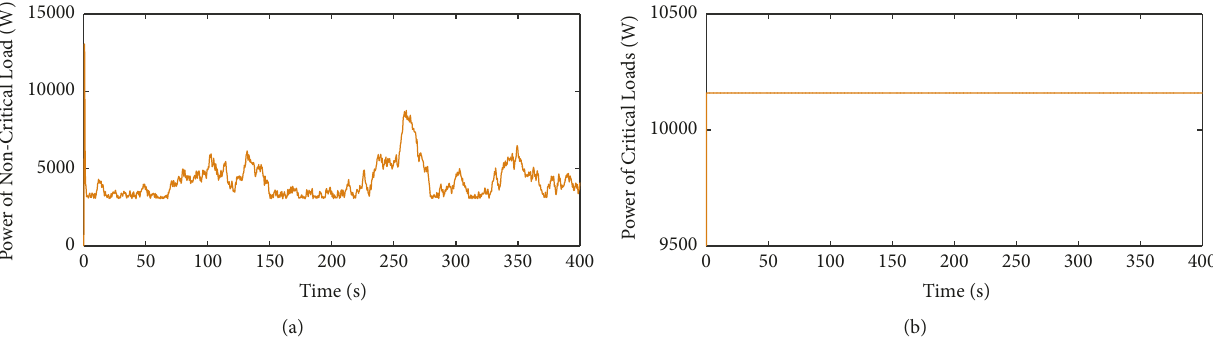
Figure 16: The input power waveform of loads when ES is activated. (a) Noncritical load. (b) Critical loads.